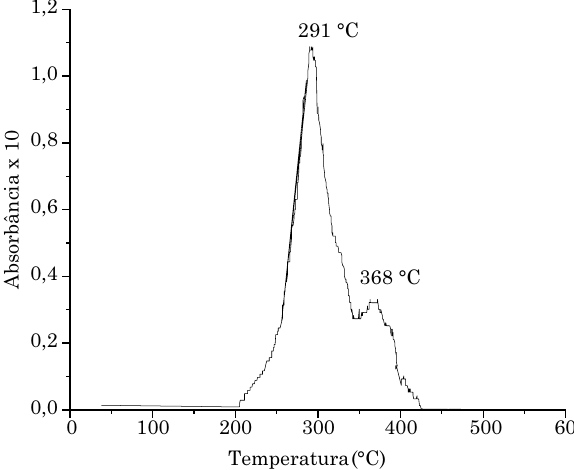
figura 1. teor de mercúrio total natural das amostras. as linhas representam os desvios-padrões da triplicata. Barras com a mesma letra para um mesmo tipo de solo indicam que não há diferença significativa entre os teores de mercúrio dos horizontes a e B (teste t, p<0,05). para os solos lVa, cXbd e pVa foi analisado apenas um dos horizontes.